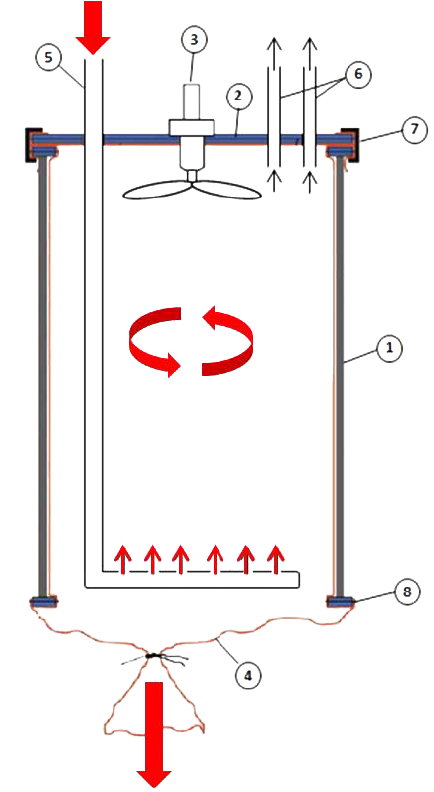
Figure 2. Layout of the dynamic cuvette as used in this study. 1 – PVC frame; 2 – acrylic glass cap; 3 – fan coated with Teflon; 4 – FEP foil; 5 – inlet PFA-tube with additional ring; 6 – sample tubes; 7 – clamps; – 8 silicon